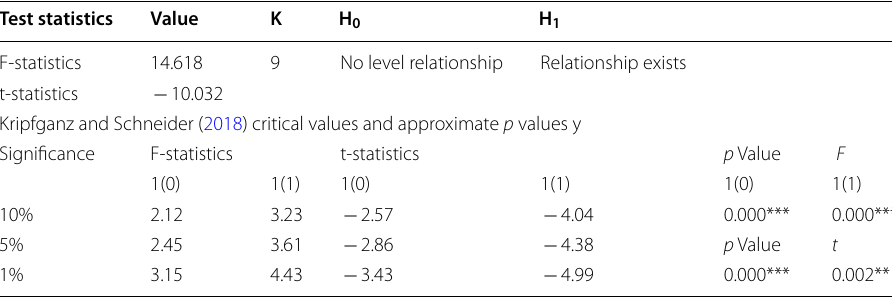
** and ***respectively represent statistical significance at 5% and 1% levels. The respective significance levels suggest the rejection of the null hypothesis of no cointegration. The optimal lag length on each variable is chosen by the Schwarz’s Bayesian information criterion